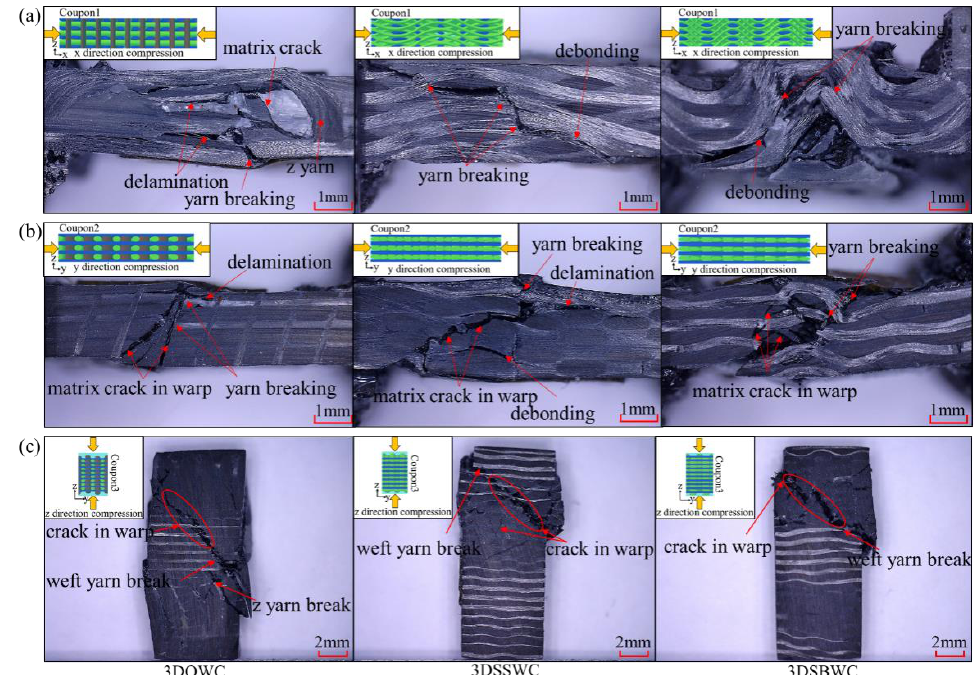
Figure 7. Compression failure mode of 3D composites in ( a ) the x-direction, ( b ) the y-direction, and ( c ) the z-direction.